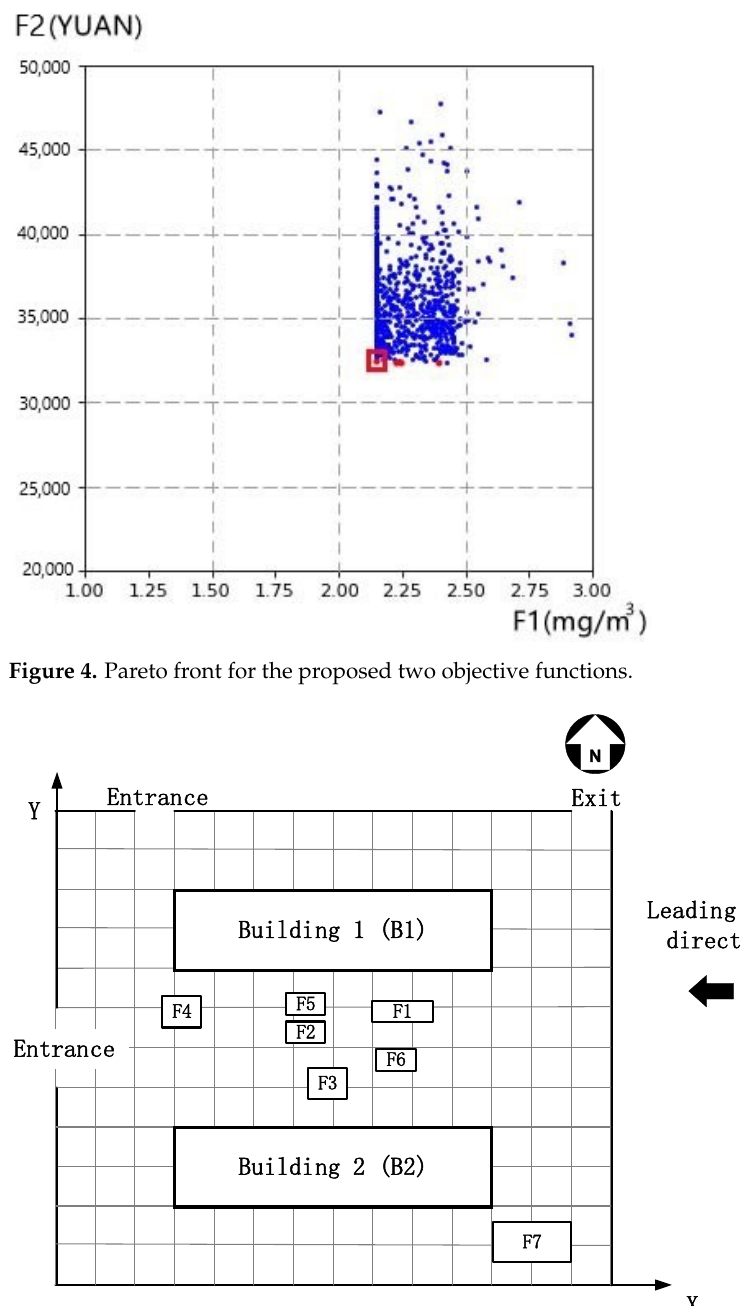
Leading wind direction Figure 6. Original construction site layout plan.